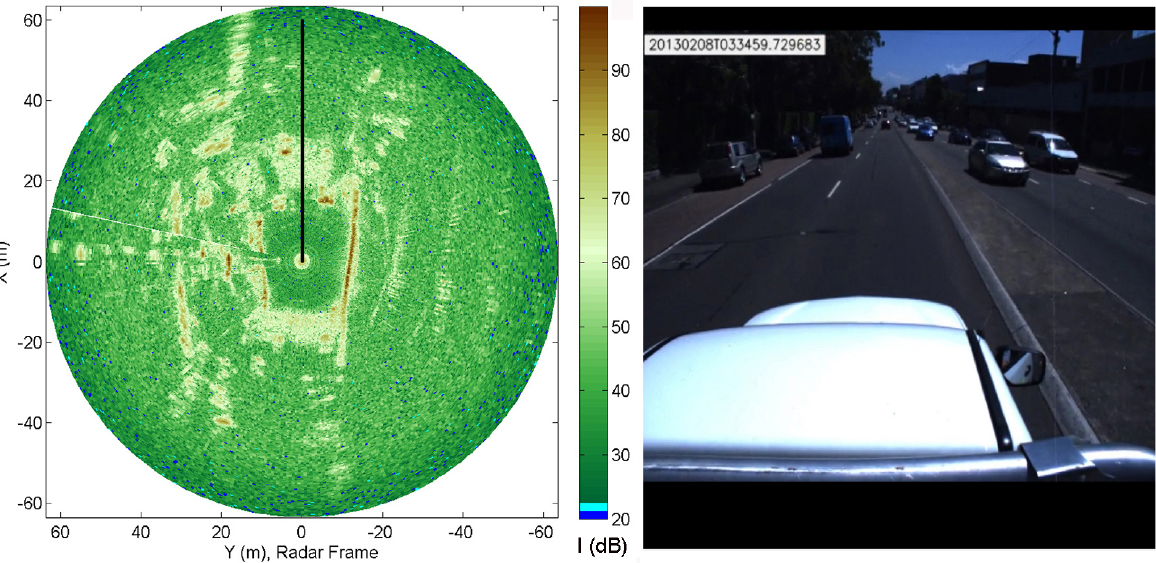
Figure 2. Example of radar image ( Left ). Note that the forward direction of the vehicle is marked by the black line. Front view of the vehicle ( Right ), as acquired by a co-located